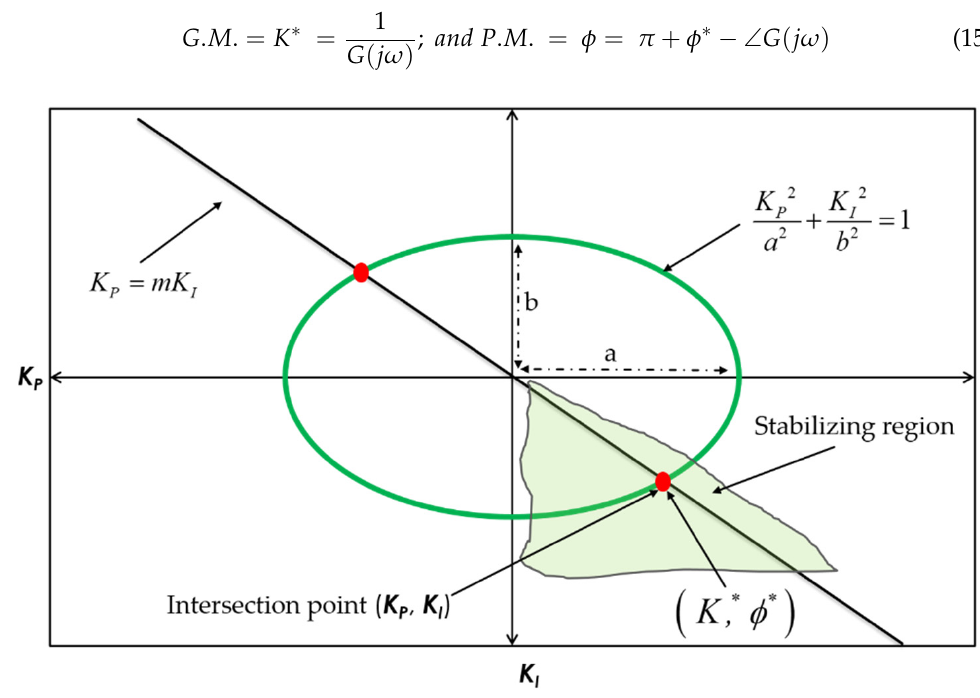
Figure 5. PI controller magnitude, phase locus along with stable region.